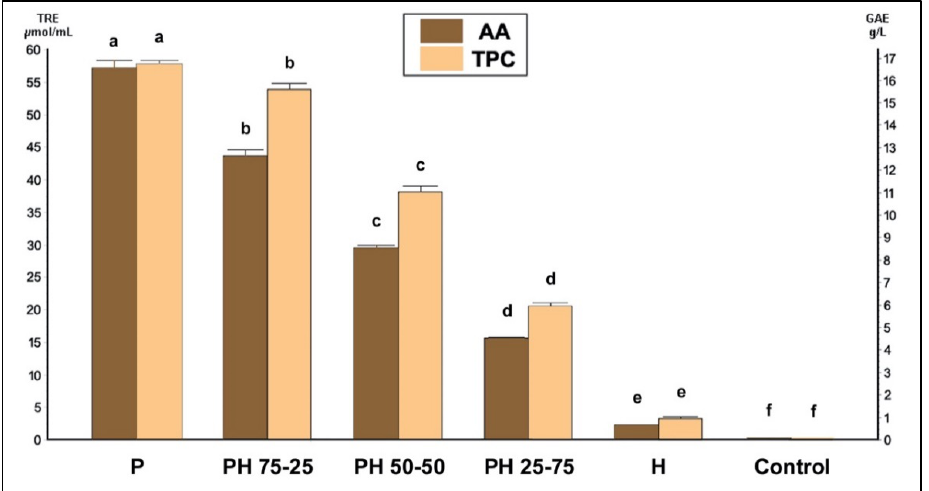
Figure 1. AA and TPC of the samples in TRE μmol /mL and g GAE/L, respectively. P: propolis tinc- ture (100% v / v ), H: honey (100% v / v ), PH: propolis and honey mixtures at the ratios indicated. Con- trol: EEVBP. Mean values followed by different superscript letters (a–f) significantly differ ( p < 0.05).